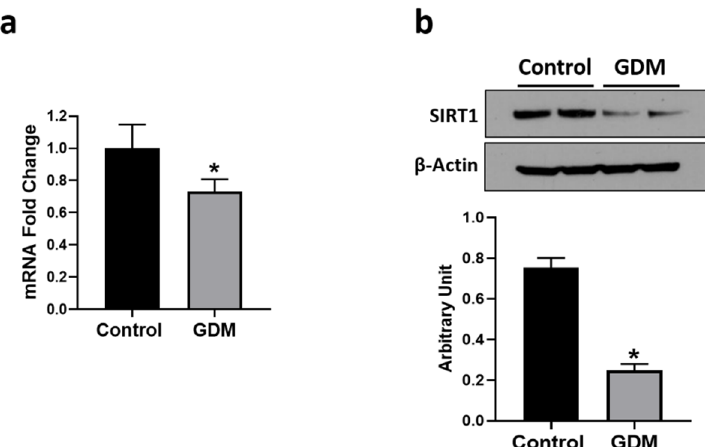
Figure 5. Changes in mRNA and protein levels of SIRT1 in the trophoblasts exposed to control and GDM conditions. Primary human trophoblasts were cultured in standard conditions or with medium containing 25-mmol/L glucose and 10 −7 -mol/L insulin for 72 h. ( a ) Real-time PCR was used to measure SIRT1 mRNA levels. ( b ) Western blotting was used for the quantification of SIRT1 protein. Representative blots for SIRT1 is shown at the top; blot density obtained from densitometric scanning of SIRT1 normalized to β-actin is shown at the bottom. Values are given as means ± SD three independent experiments. * p < 0.05 vs. control.